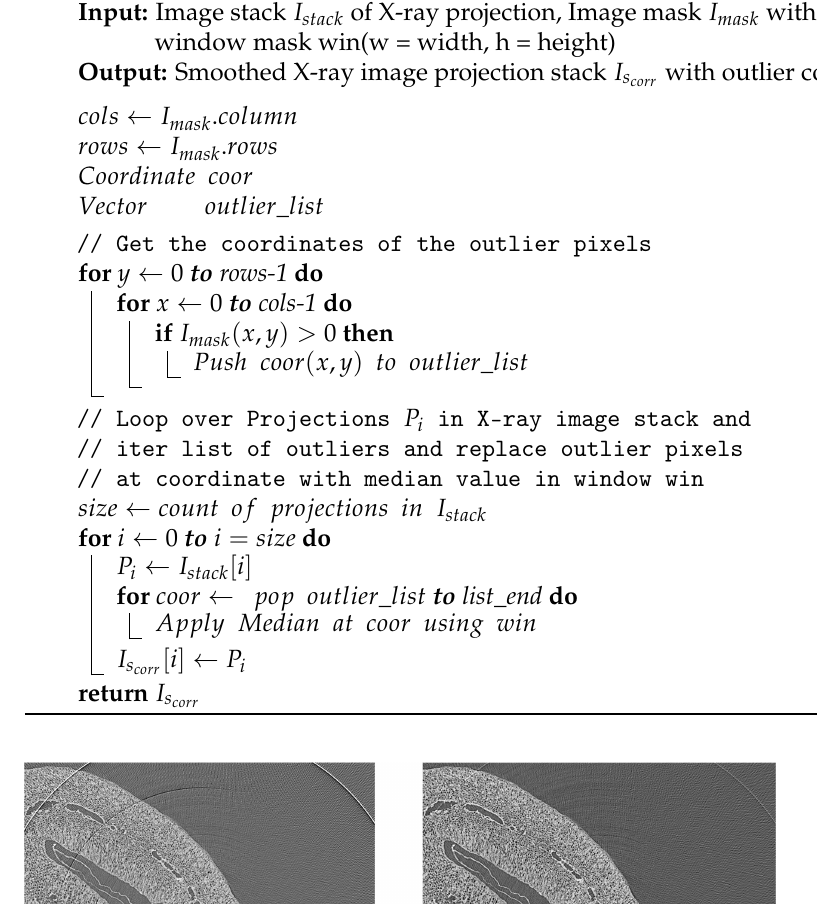
Algorithm 2: Median filtering of defect pixels in X-ray projections.